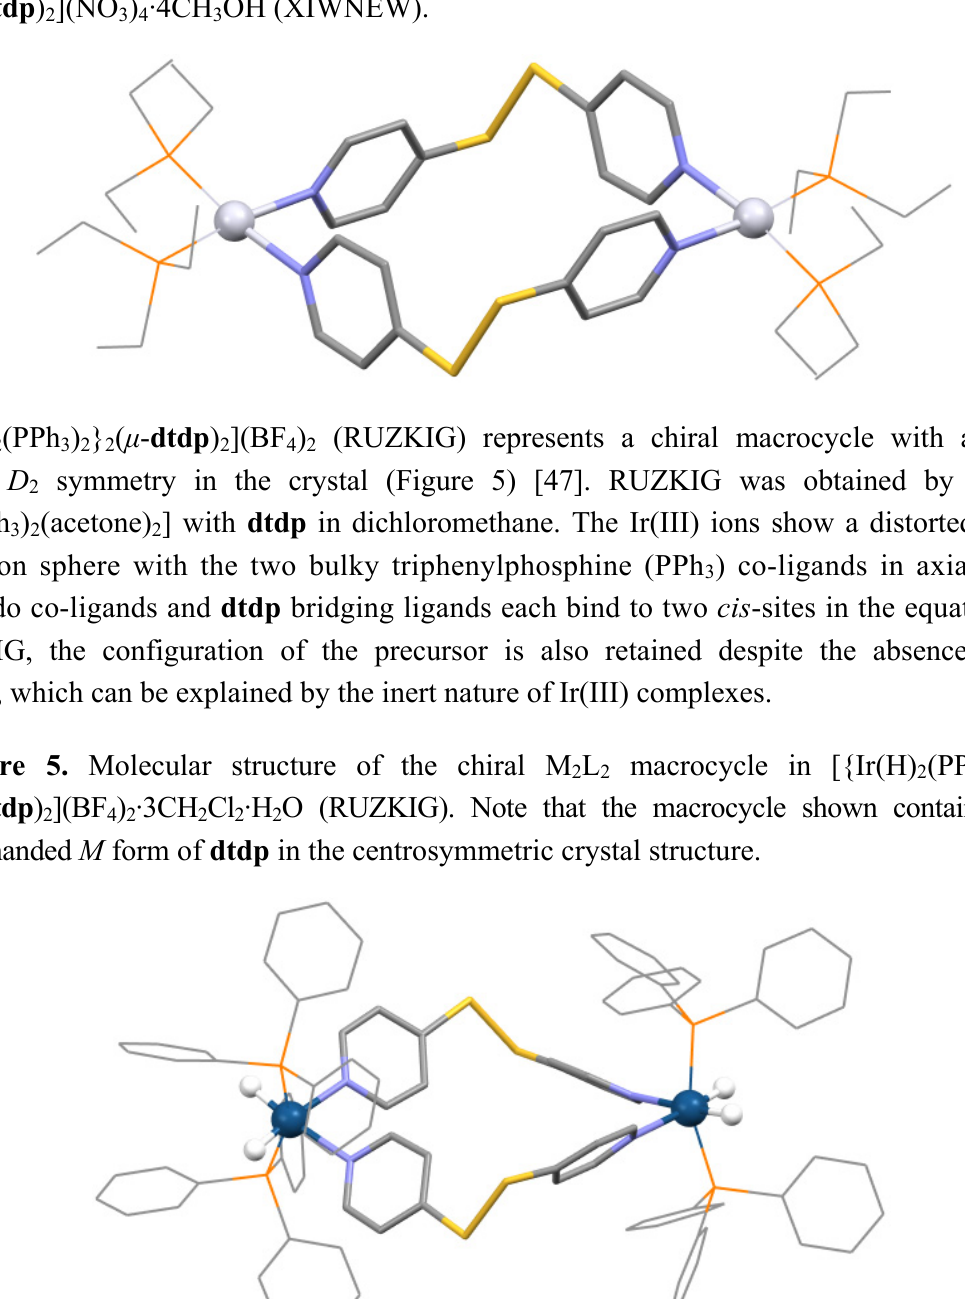
L macrocycle in [{Pt(PEt 2 2